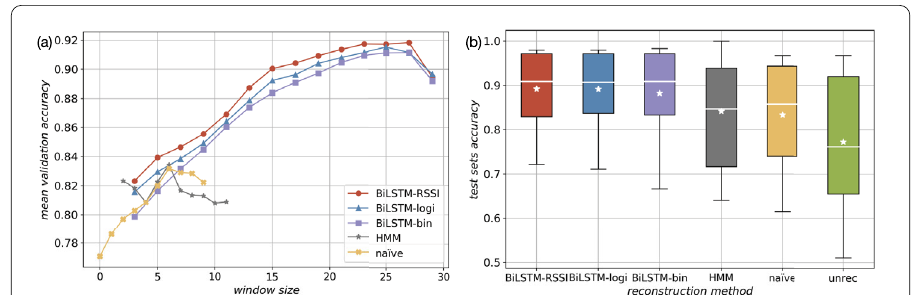
Figure 4 Accuracy of temporal network reconstruction ( a ) Average validation accuracy values as a function of window size for the naïve, HMM, BiLSTM-bin, BiLSTM-logi and BiLSTM-RSSI models, with fixed number of hidden neurons for BiLSTM models as summarised in Table 2. ( b ) Distribution of accuracy values shown as box-plots for the different models with optimal hyper-parameters values summarised in Table 2. Horizontal white bar inside box is median and white star is